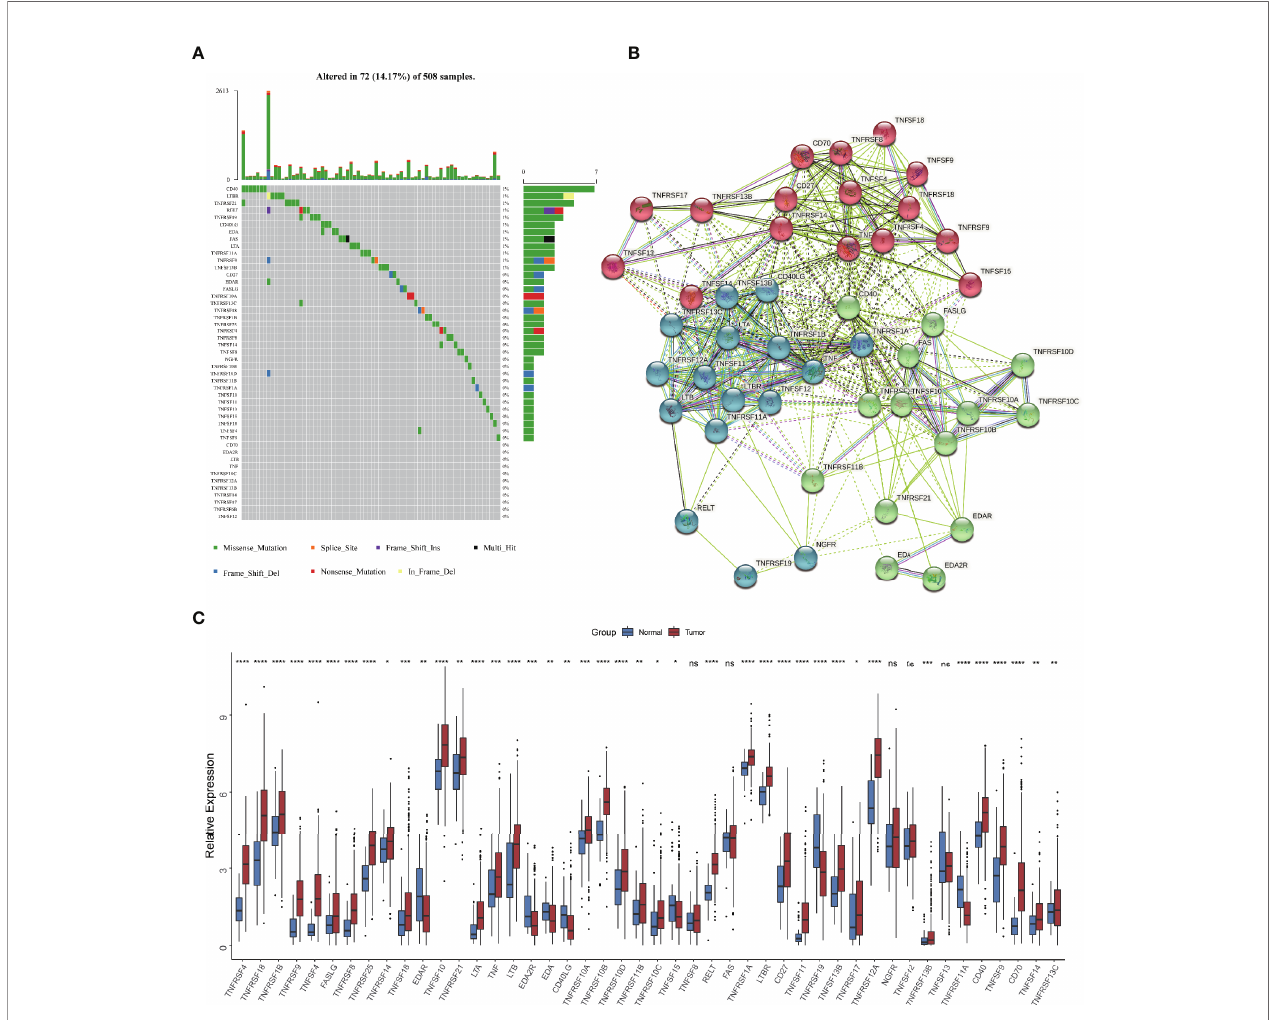
FIGURE 1 | Multi-omics landscape of TNF family in HNSCC. (A) The mutation frequency of 46 TNF family proteins in TCGA HNSCC cohort. Each column of the fi gure represents an individual patient. (B) The protein-protein interaction network among TNF family proteins. (C) Boxplot shows the expression of 46 TNF family proteins between tumor and normal tissues in TCGA HNSCC cohort. (* p < 0.05, ** p < 0.01, *** p < 0.001, **** p < 0.0001, ns, not signi fi